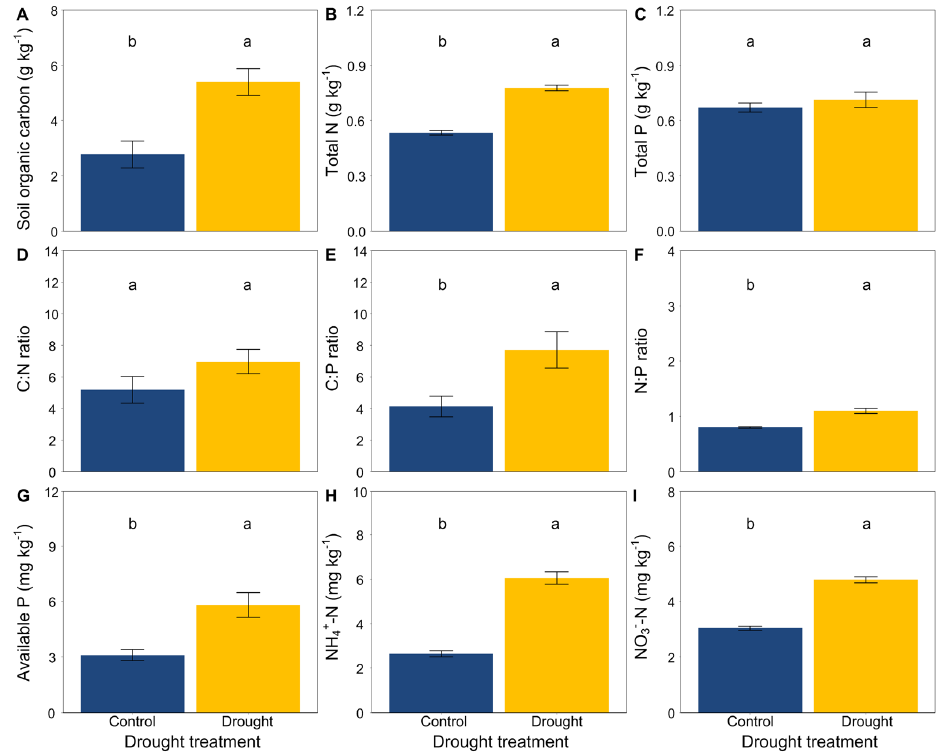
Figure 3. Effects of drought on ( A ) soil organic carbon, ( B ) total N, ( C ) total P, ( D ) the C:N ratio, ( E ) the C:P ratio, ( F ) the N:P ratio, ( G ) available P, and ( H , I ) inorganic N (NH 4+ -N and NO 3 − -N). Mean ± SE are shown (n = 12). Within each panel, different lowercase letters indicate significant differences at p < 0.05 (Tukey’s HSD).